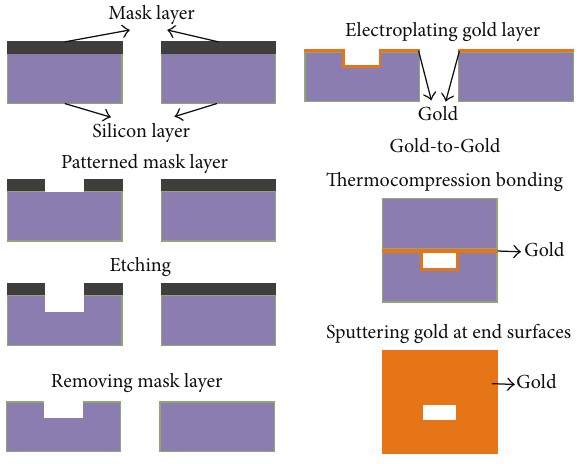
Figure 9: Test fixtures with the modified ring-centered flanges.